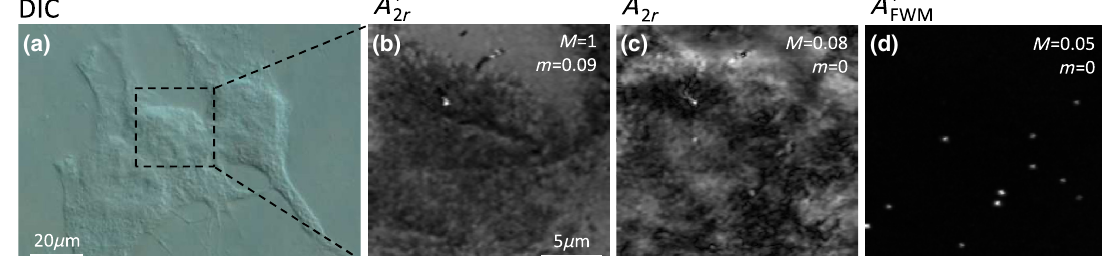
. FWM , and (i) phase Φ þ . FWM was acquired FWM FWM